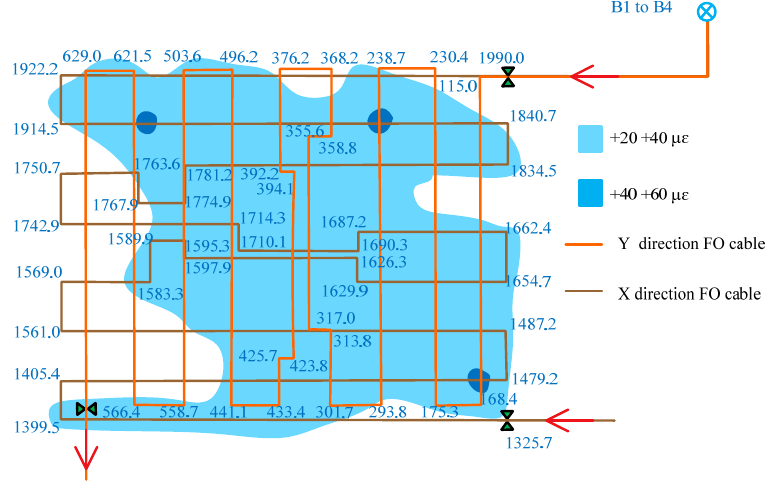
Figure 13. Zones subjected to tension strains.